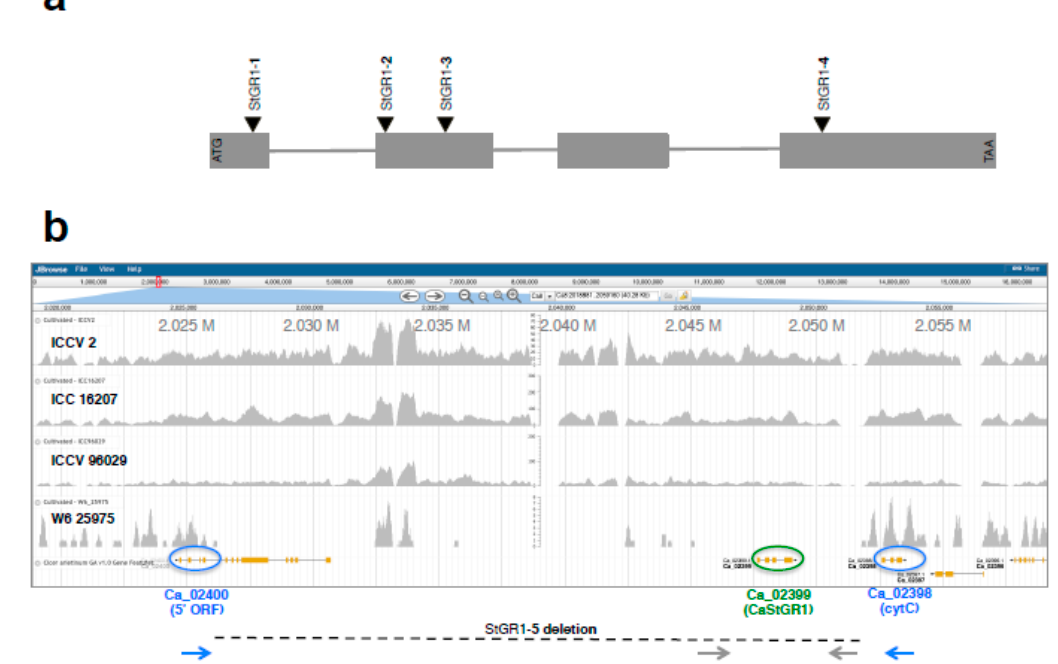
Figure 2. Gene structure and genomic context of type chickpea stay-green gene CaStGR1. ( a ) Schematic of the gene structure of CaStGR1 are shown in ( a ), with the four exons denoted by gray boxes and the three introns as thin lines. Locations of the four small deletion alleles CaStGR1 through CaStGR4 are denoted by triangles above the exons. ( b ) Whole genome Illumina short read skim sequencing read pileups of three normal yellow cotyledon colored chickpea genotypes (ICCV 2, ICC 16,207 and